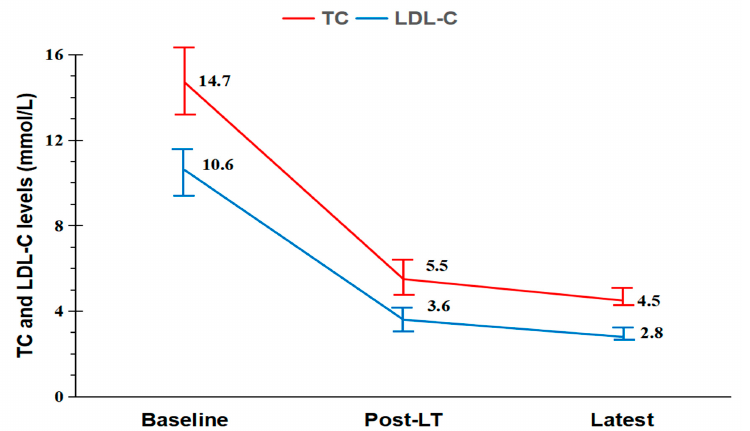
Figure 1. Changes in serum TC and LDL-C levels over time. Baseline levels were obtained in the immediate preoperative period. Post-LT levels were defined as those measured at normalization,